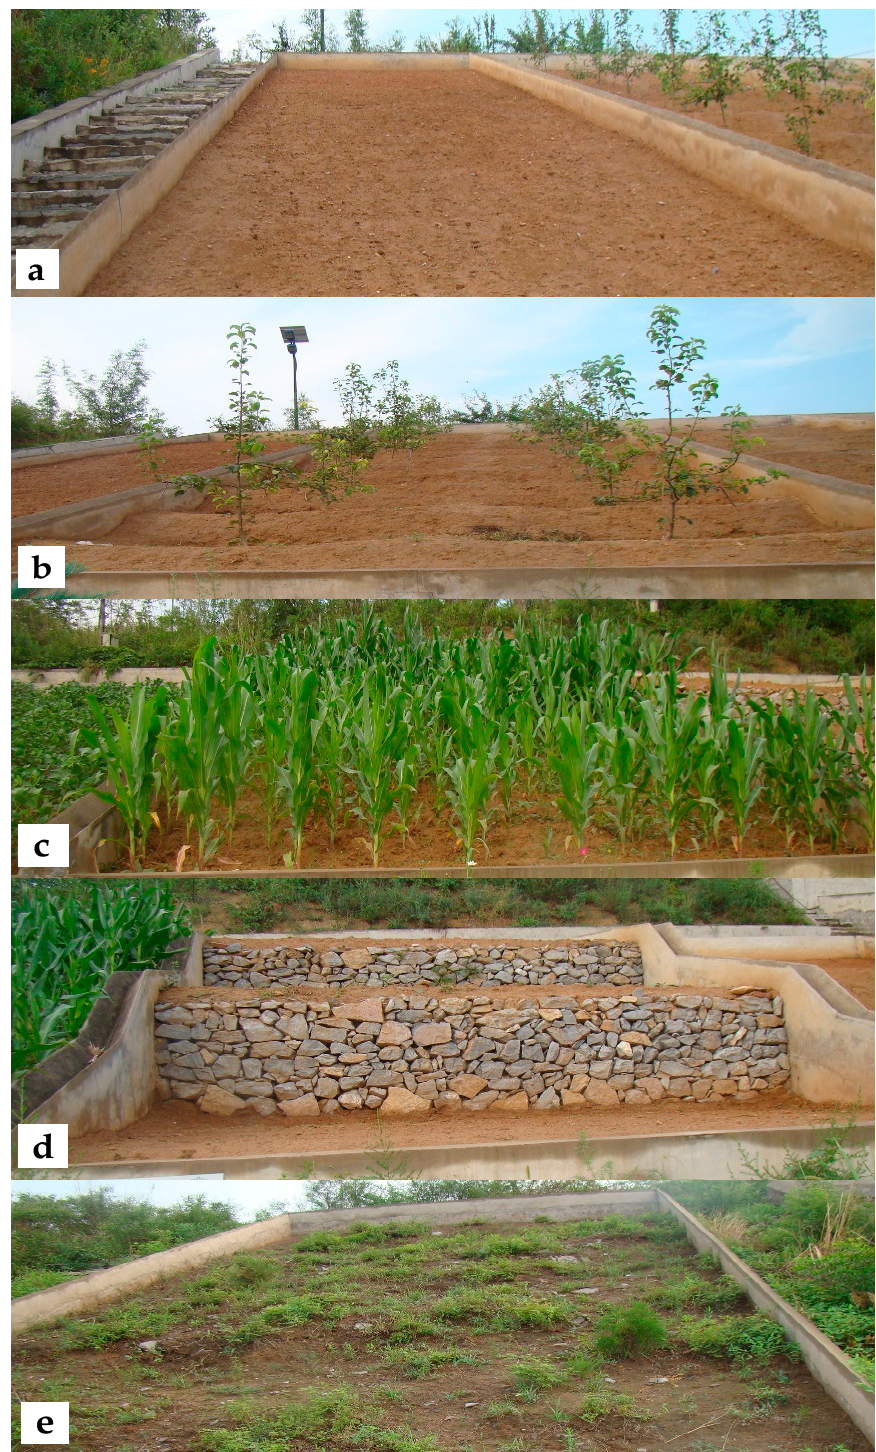
Figure 2. Runoff sites (( a ) is bare land; ( b ) is fish-scale pits site; ( c ) is agricultural land; ( d ) is narrow terraces; ( e ) is shrub 30% site).